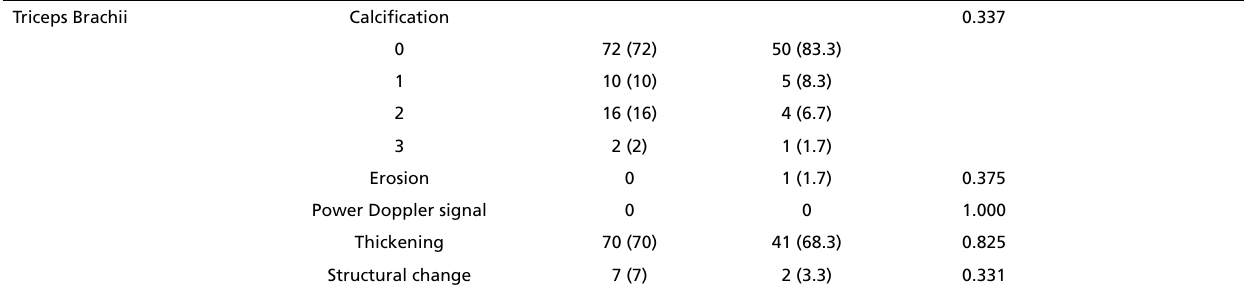
Table 3 - Continuation Triceps Brachii